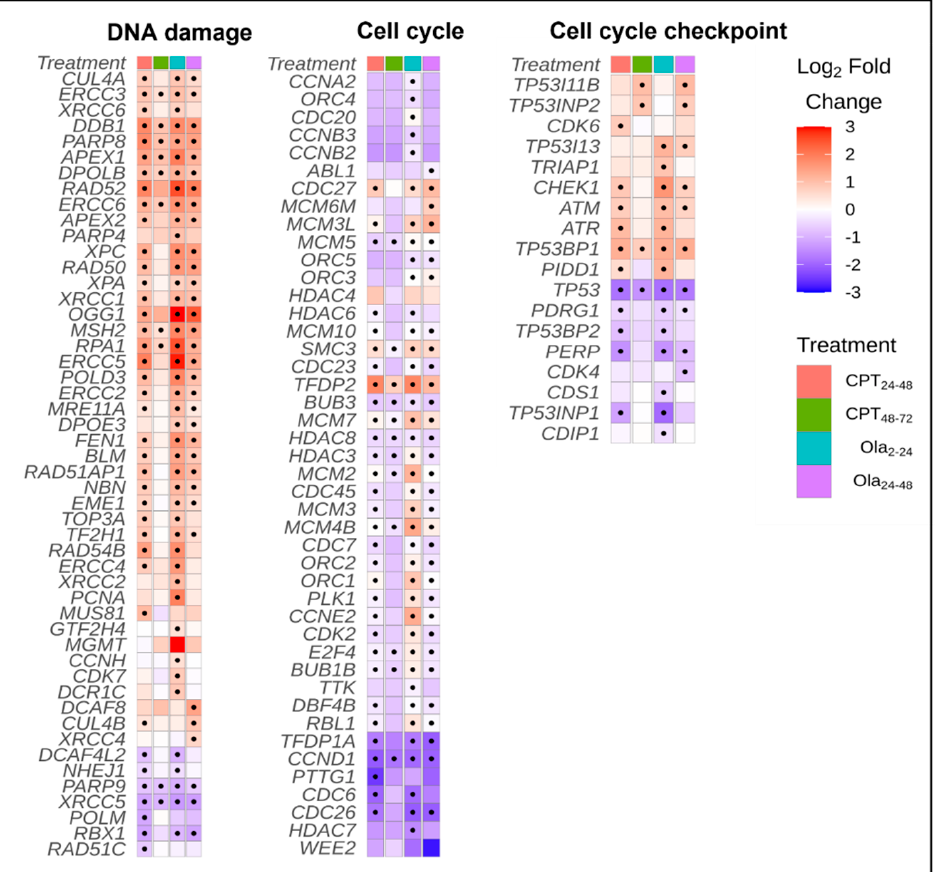
Figure 6. Genes associated with DNA damage, cell cycle, and cell cycle checkpoint control that were significantly (padj < 0.1) differentially expressed in at least one of the treated samples relative to the control in sterlet ( A. ruthenus ). The color scale represents the log2 fold-change between the treatment and the control and is capped at a maximum of 3 and a minimum of -3. A black dot represents the genes that were differentially expressed.